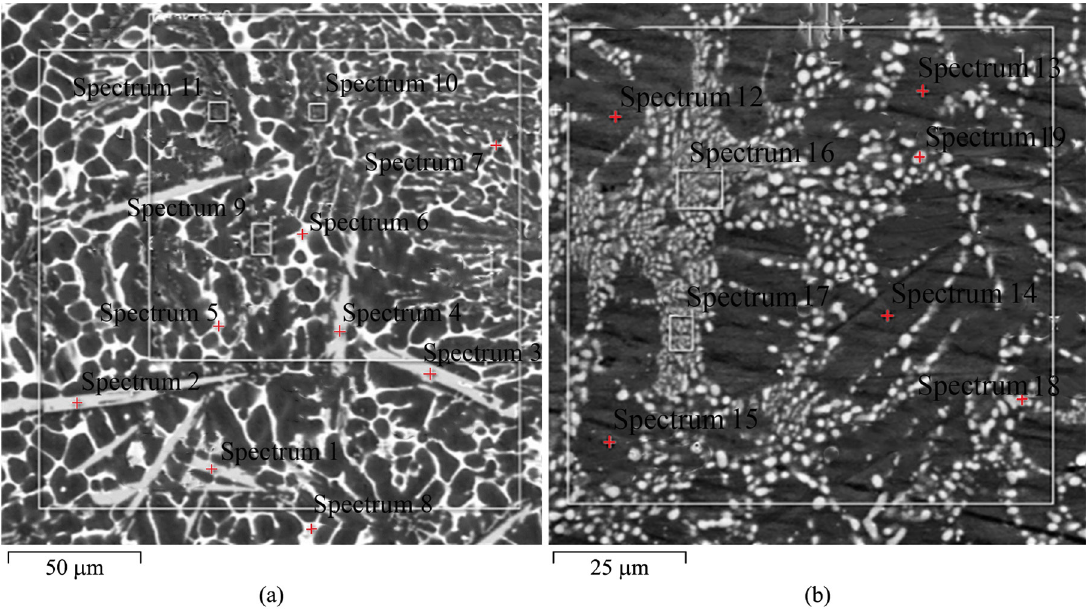
Figure 5. Results of energy-dispersive X-ray spectroscopy (a) Al-12%Zn-4%Ca-3.5%Mg alloy in as-cast state; (b) Al-9%Zn-3%Ca-3.5%Mg alloy in as‑quenched state (500 °С), SEM/EMPA.